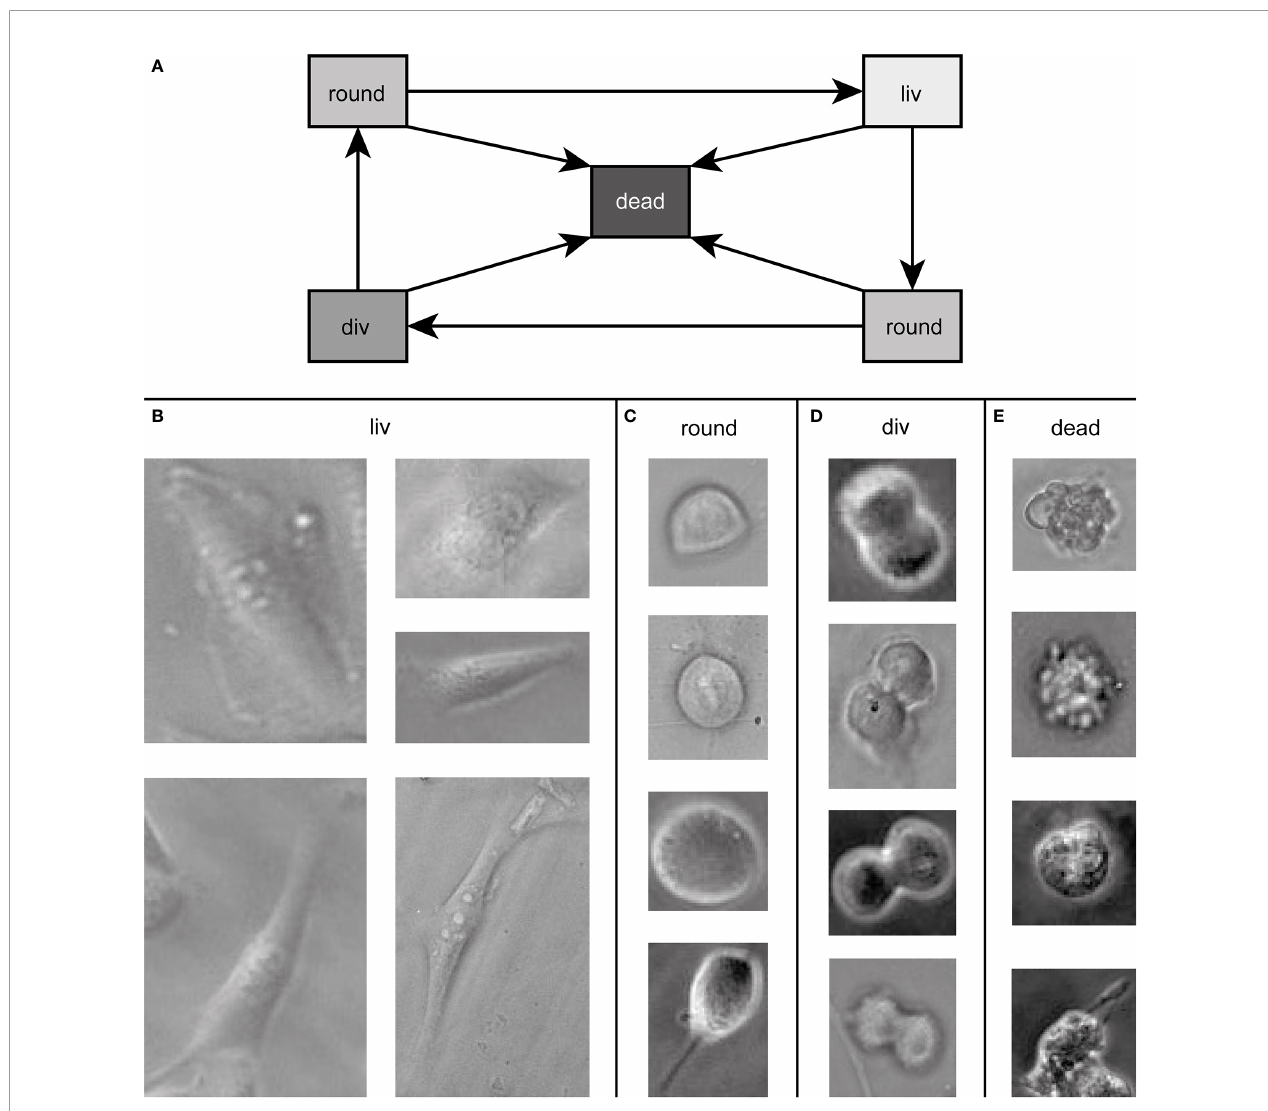
FIGURE 1 | In (A) all possible transitions between the classes are depicted. Example images of cells of the dataset in the four states are shown in (B – E) de fi ning the classes for training. The contrast of the raw data images was enhanced for better visibility and raw data can be found in the Supplementary Figure 2